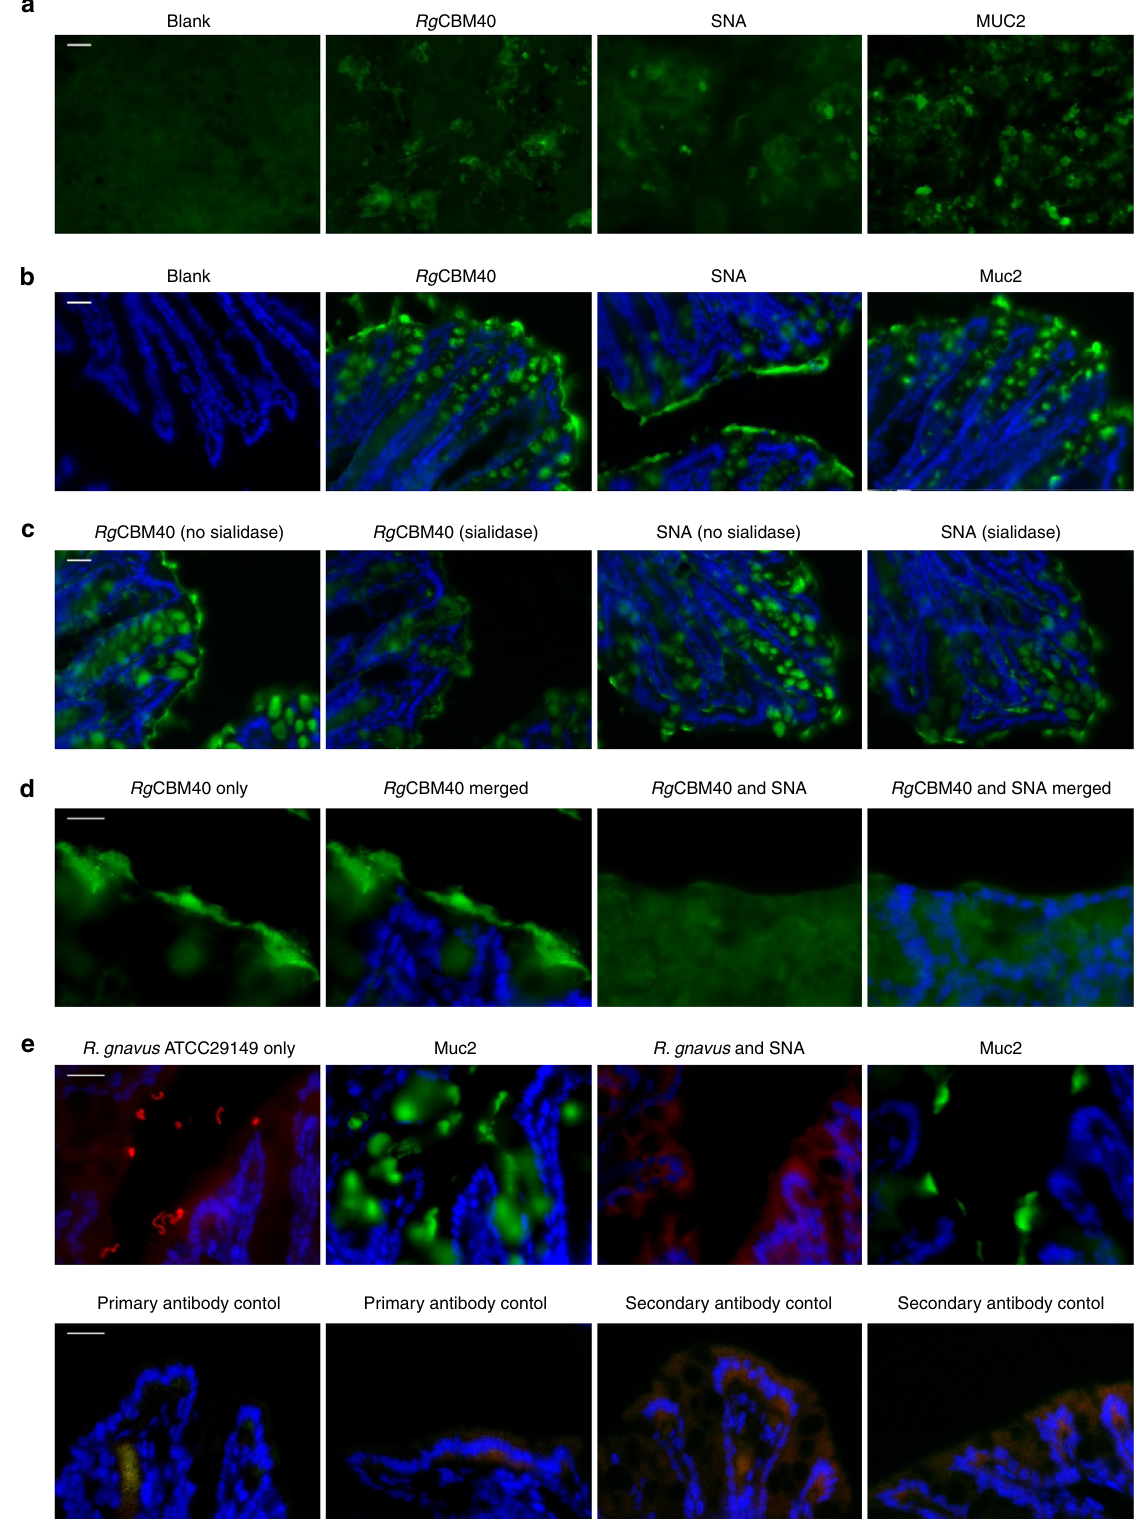
SNA (Fig. 8e), con fi rming the importance of sialic acid recognition in R. gnavus ATCC 29149 binding to